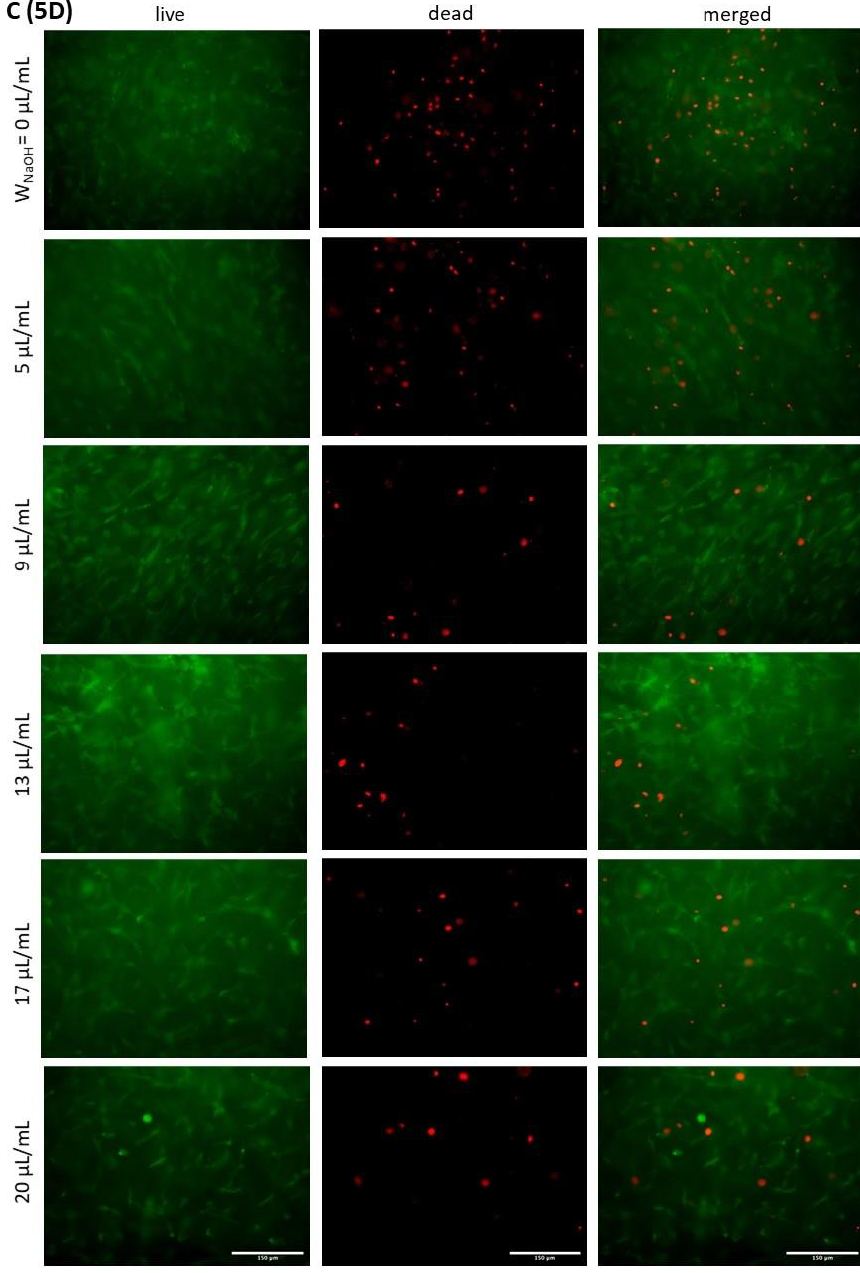
Figure 10. ( A – C ). The viability of cells in samples after 0 (6 h; ( A )), 3 ( B ) and 5 ( C ) days of cultivation. Cell viability was examined using FDA/PI staining. Green cells were alive, and red cells were dead. Leica DMi8 microscope with N-Plan objective 20×, scale bar 150 μ m.